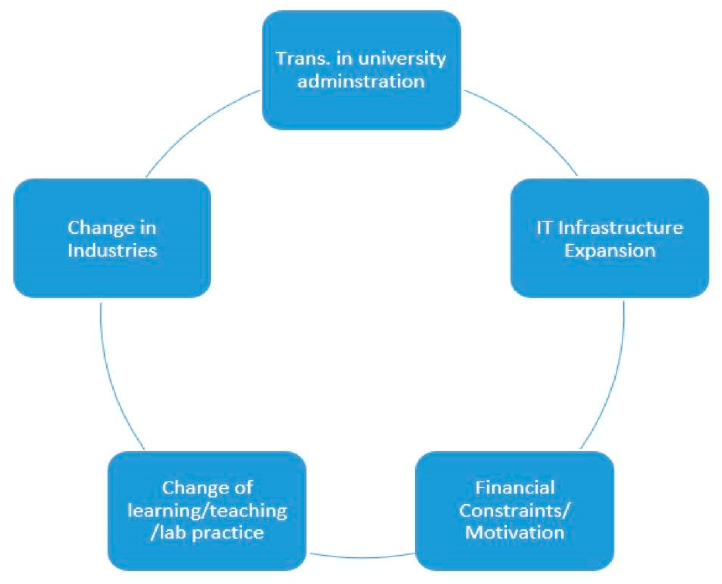
Figure 1. The summary of transformation inside educational programs.